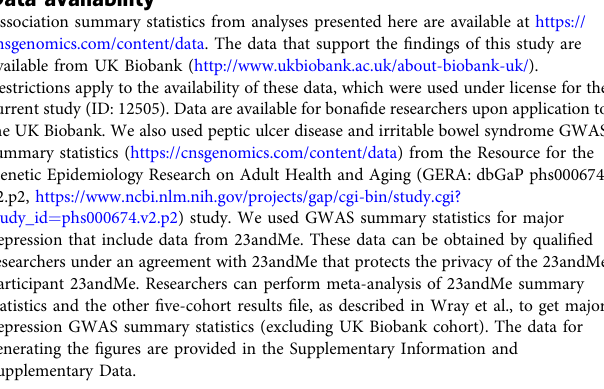
Fig. 6c is based on association P value thresholds 1.0E − 2. Given the availability of depression and psychiatric disorders (not GORD) phenotypes in GERA cohort,